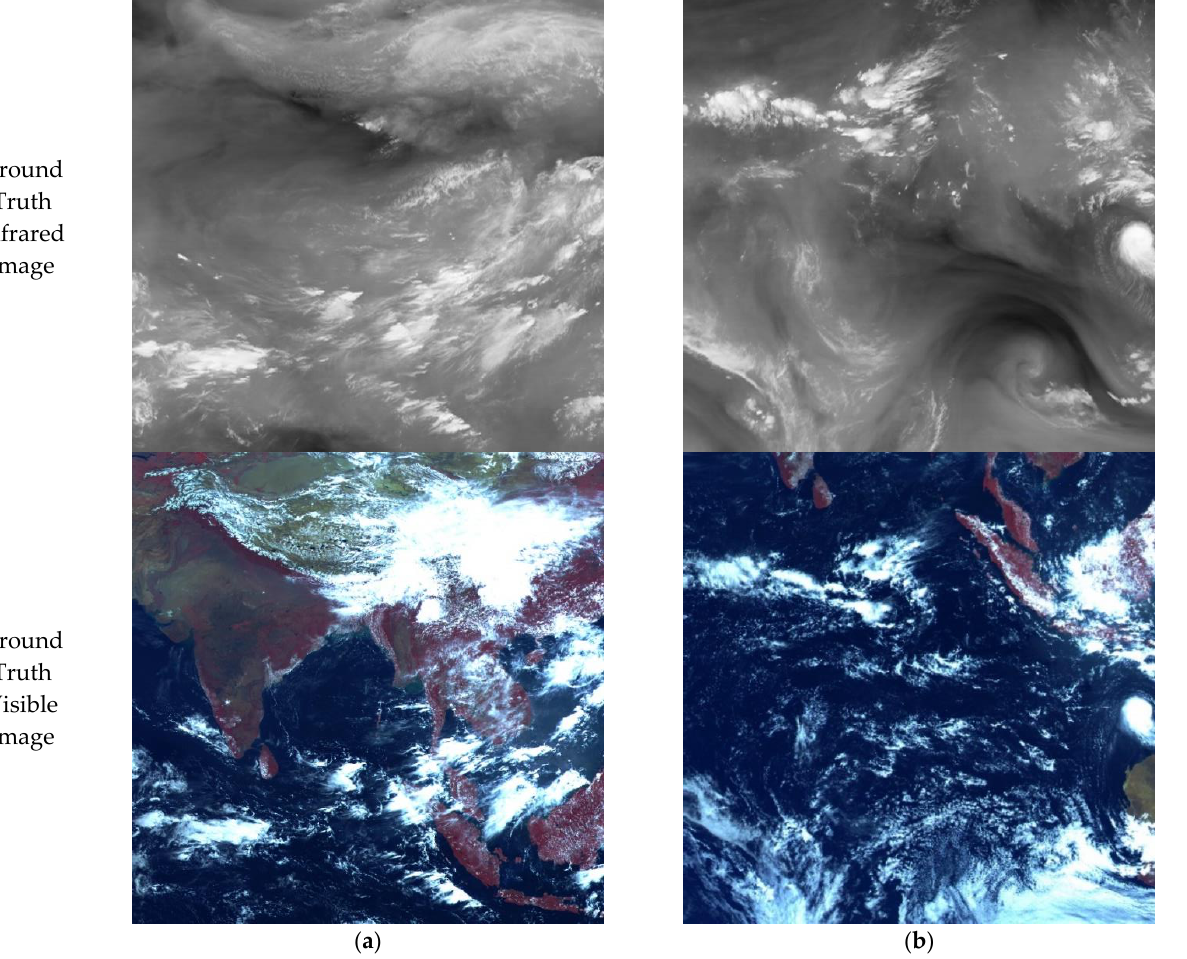
Figure 3. The input spectral-domain images and condition information of the two sets of visual comparison experiments. The first line presents label maps of the earth surface type; the second line presents cloud-type label maps; the third line presents the ground-truth of the infrared remote sensing image; and the fourth line presents the ground-truth of the visible remote sensing image. Subfigures ( a ) and subfigures ( b ) are two independent test cases.